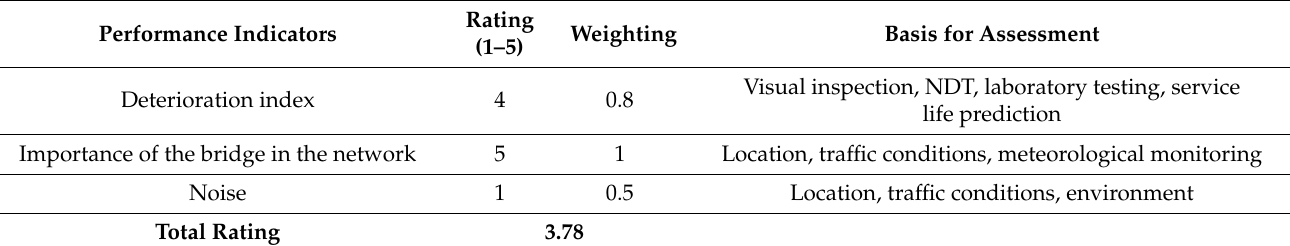
Table 12. Assessment of key performance indicators related to health and